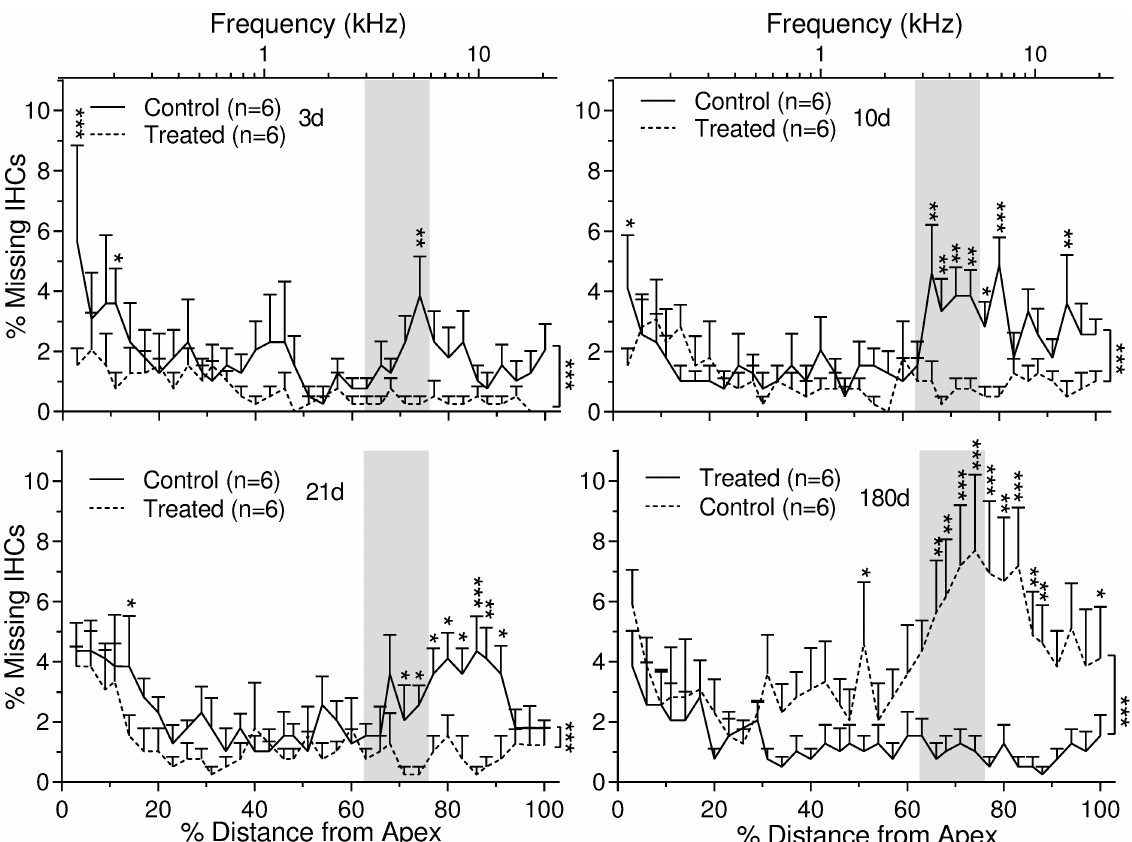
Fig 10. Percent of inner hair cell (IHC) loss as a function of percent distance (and tonotopic position in kHz) from the OC apex in untreated and HPN-07-treated chinchilla at 3 days, 10 days, 21 days and 6 months after noise exposure. Significantlyless IHC loss was observedin the basal turn of the OC in the HPN-07 treatment group ( p < 0.05, 0.01 or 0.001). The data are plotted as mean ± SEM, and “n”represents the number of cochleae.Vertical lines at right of figures show a significant difference of mean values for control (untreated)and HPN-07-treated" groups as determinedby two-way ANOVA followedby Bonferroni post-tests: * p < 0.05; ** p < 0.01; *** p < 0.001. Shaded area demarcates the range of noise exposure centeredat 4